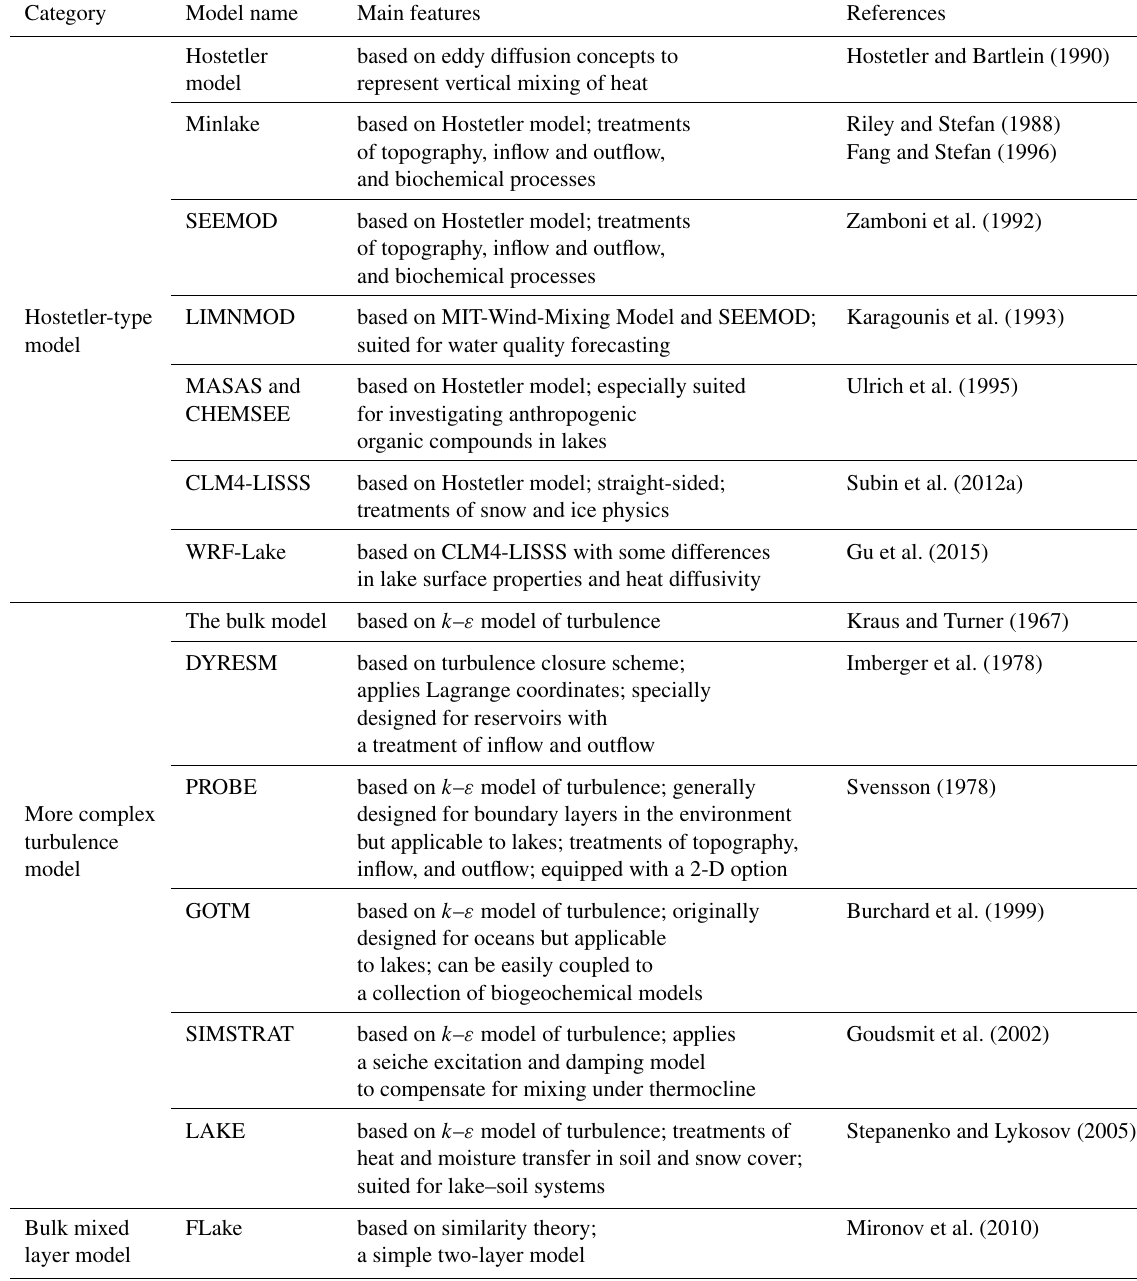
Table 1. Common 1-D lake